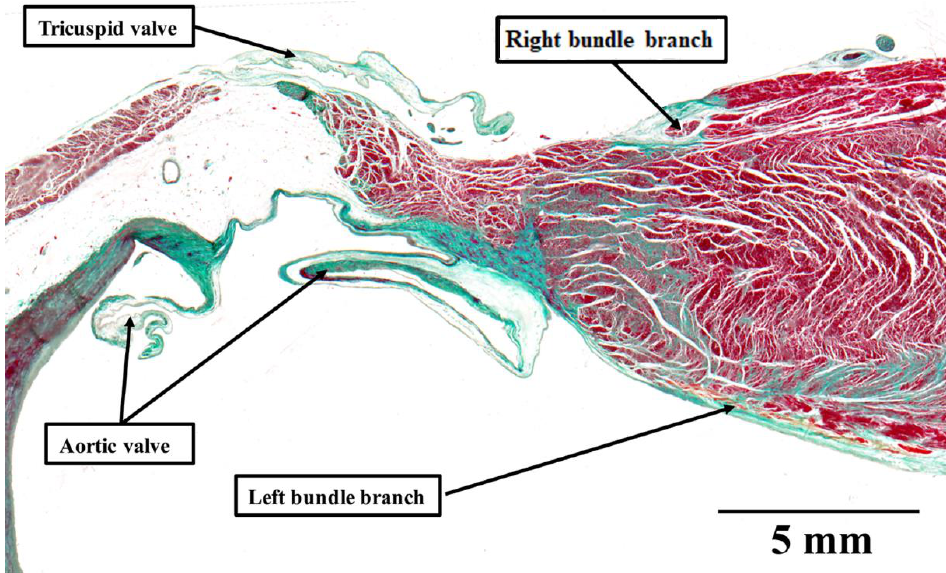
Figure 5. Mönckeberg and Aschoff’s criteria for a conducting tract: The histological section shows the crest of the ventricular septum in a human heart stained using the trichrome technique. The right bundle branch is insulated by a sheath of fibrous tissue, colored green. This makes it possible to distinguish the bundle from the adjacent myocardium, and follow the bundle in serial sections. Thus, the structure satisfies all of the criteria established by Mönckeberg and Aschoff [3,4] for recognition as a conducting tract.